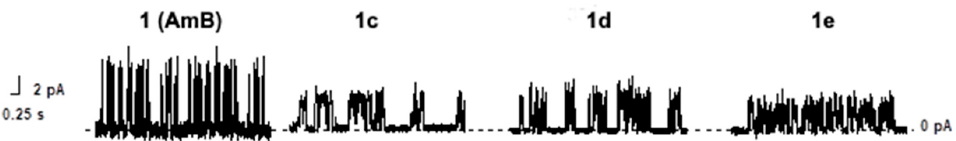
Figure 4. Current fluctuations corresponding to openings and closures of single channels induced 2.0 M KCl (pH 7.4). The transmembrane voltage was equal to 200 by AmB, 1d , 1c and 1e in the lipid bilayers composed of DPhPC/ERG (67/33 mol %) and bathed in 2.0 M KCl (pH 7.4). The transmembrane voltage was equal to 200 mV.